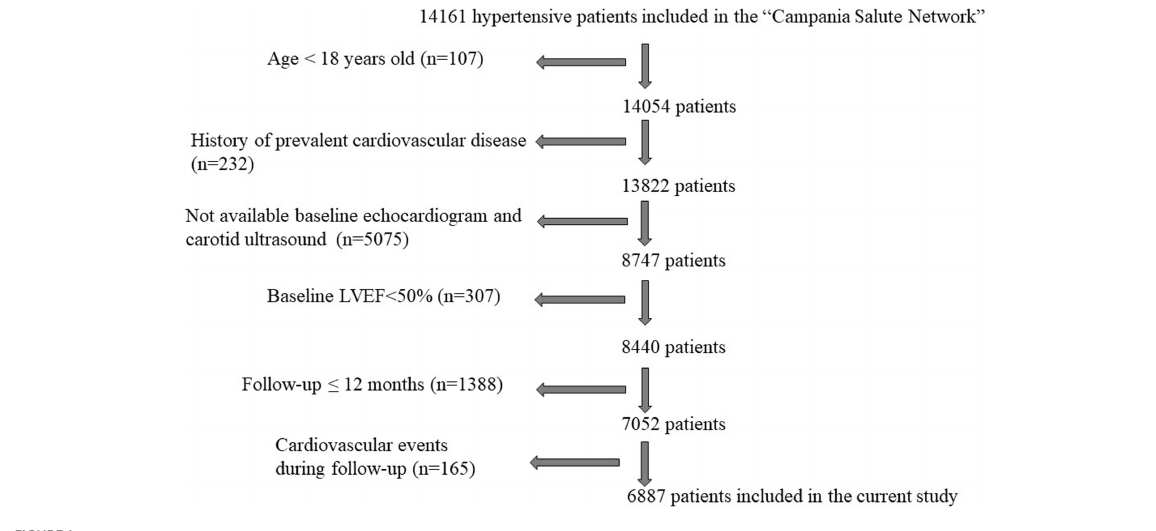
stroke volume and LV EF, and lower values of left atrial volume